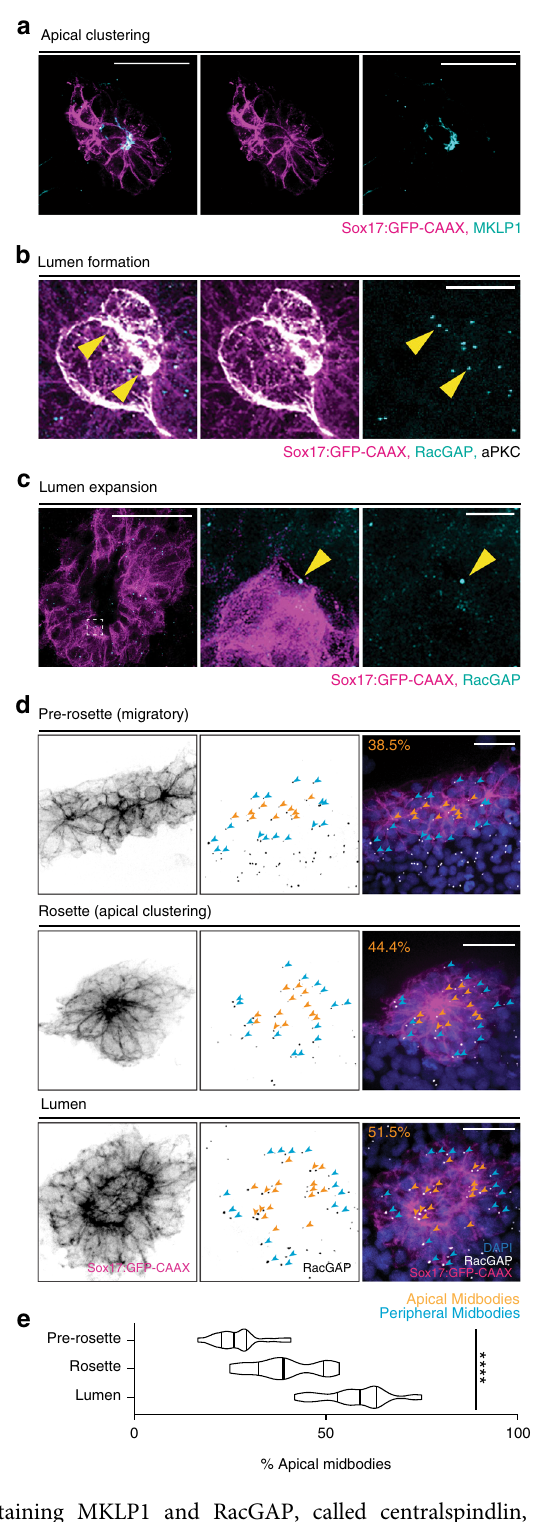
Fig. 2 Cytokinetic midbodies localize to apical membranes of lumens in vivo. a – c Maximum confocal projections of KV in zebra fi sh embryos during apical clustering ( a ), lumen formation ( b ), and lumen expansion ( c ). Immunolabeled for midbodies (MKLP1 ( a ) or RacGAP ( b , c ) — cyan), a polarity marker (aPKC ( b ) — white), and a membrane marker (Sox17:GFP- CAAX — magenta). Bars, 50 μ m ( a , c ), 20 μ m ( b ), and 10 μ m ( c inset). Midbodies localizing to apical membrane during KV lumen formation and lumen expansion denoted by yellow arrowheads ( b , c ). d Representative images of midbody localization (RacGAP — white) within KV (Sox17:GFP- CAAX — magenta and DAPI — blue). Pre-rosette (top), rosette (middle), and lumen (bottom) stages of KV development depicted. Orange arrowheads denote apical midbodies; cyan arrowheads denote peripheral midbodies. Bar, 50 μ m. e Violin plot depicting percentage of apical midbodies in KVs at pre-rosette ( n = 21 embryos), rosette ( n = 16 embryos), and lumen ( n = 35 embryos) stages. Endpoints depict minimum and maximum values, quartiles depicted by thin black lines, median depicted by thick black line. n > 4 independent experiments. One-way ANOVA, **** p < 0.0001, F(2,69) = 104.7, df =